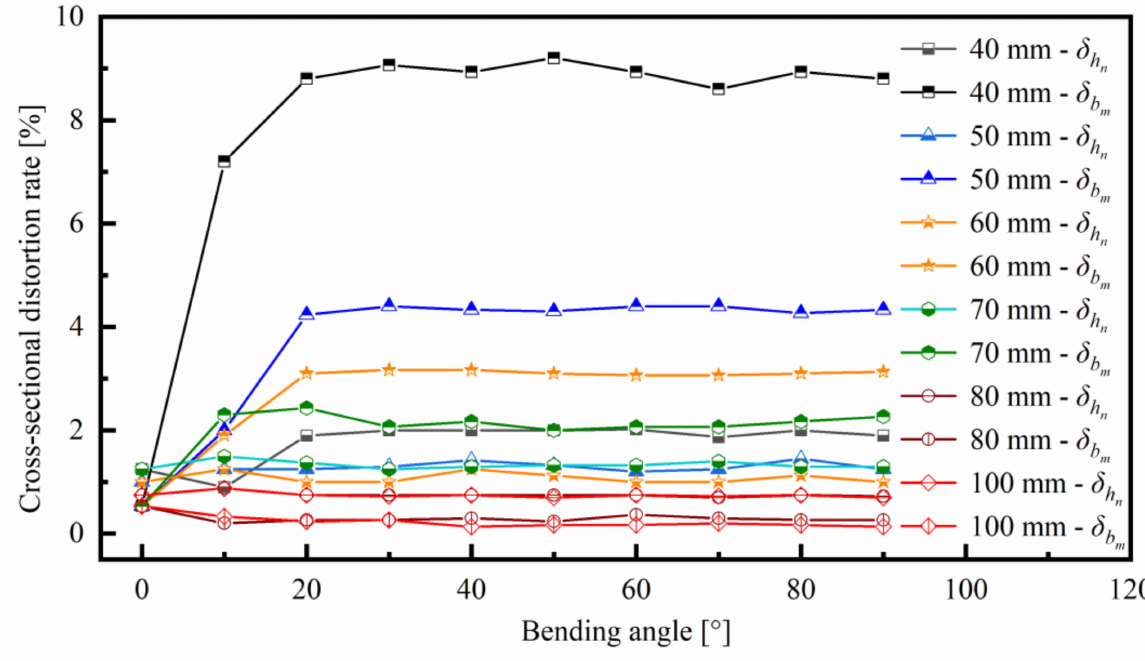
Figure 25. Experimental results with difference distances between the inductor and the bending roller (feed rate of the tube: 10